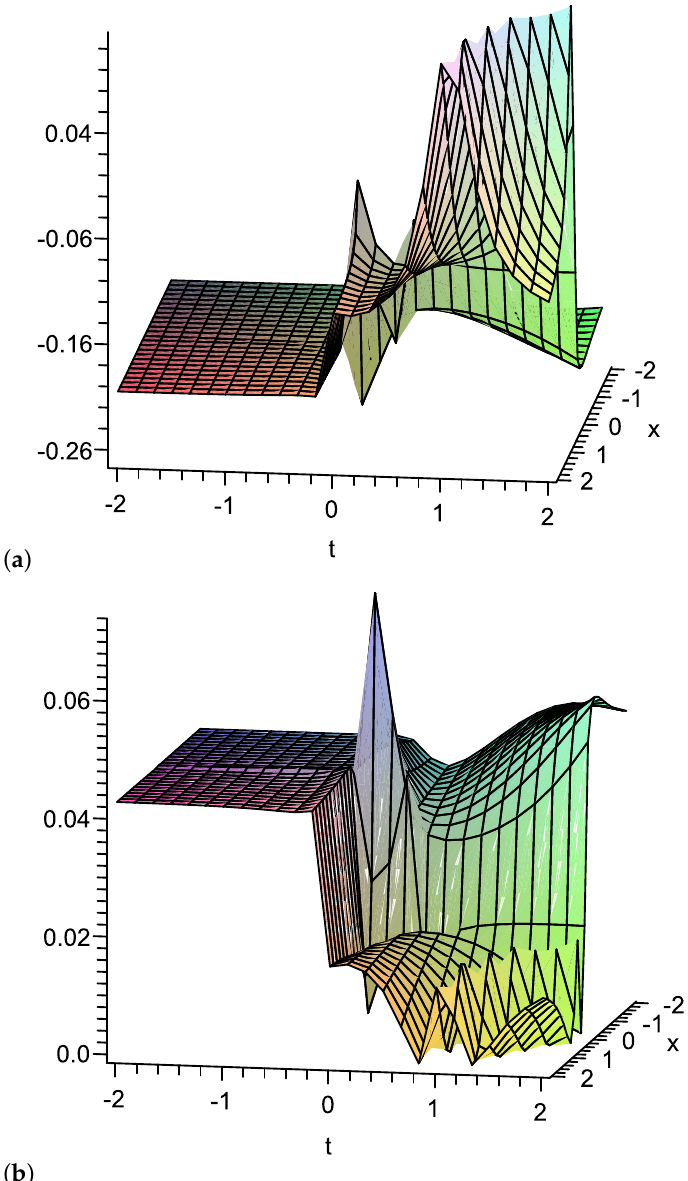
where α is a beta random variable. The mean value E [ ˜ sq respectively.